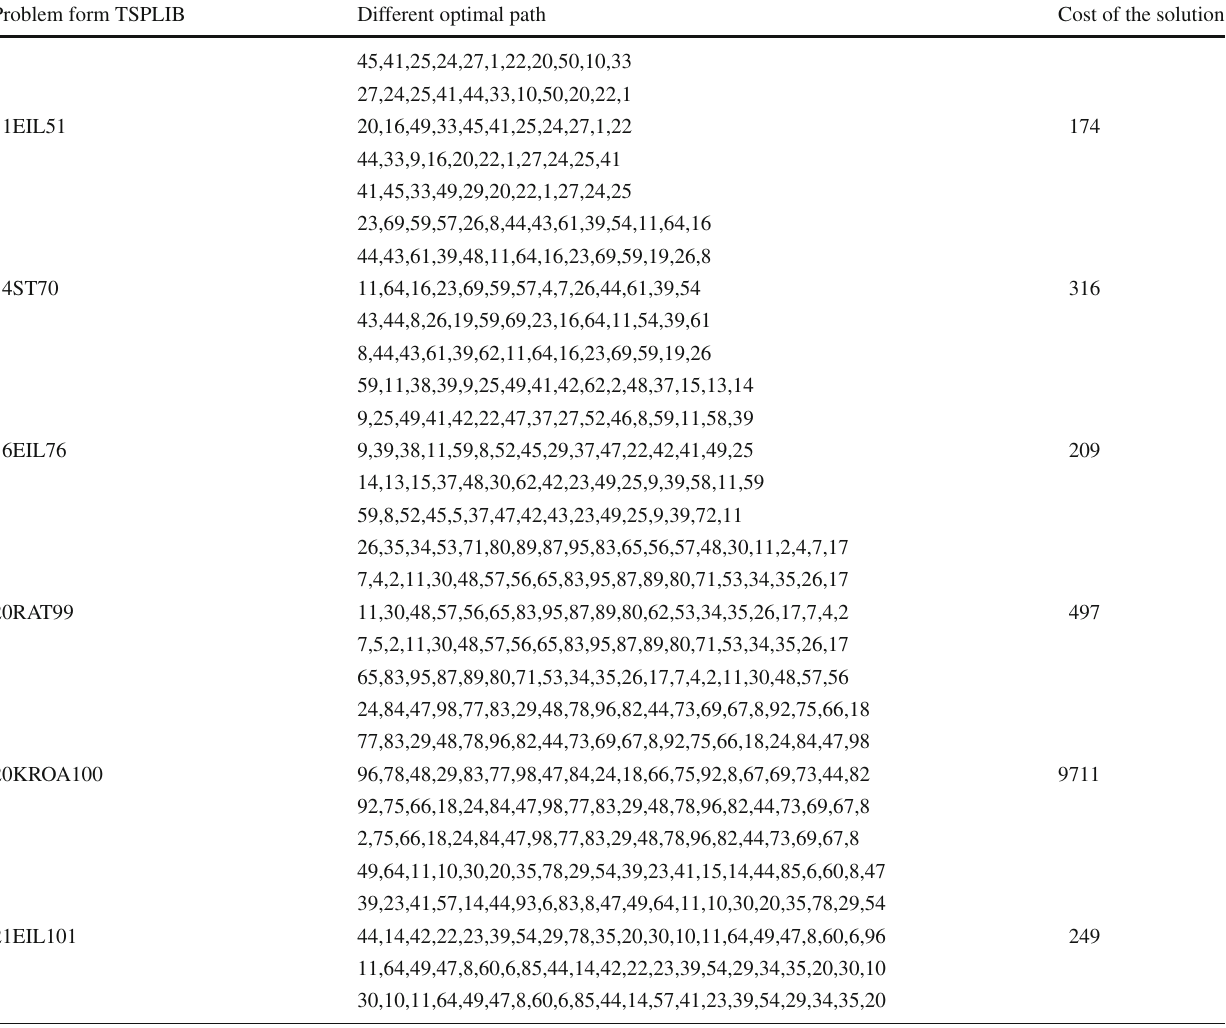
Table 2 Different optimal paths of some test problems from TSPLIB obtained by the algorithm Problem form TSPLIB Different optimal path Cost of the